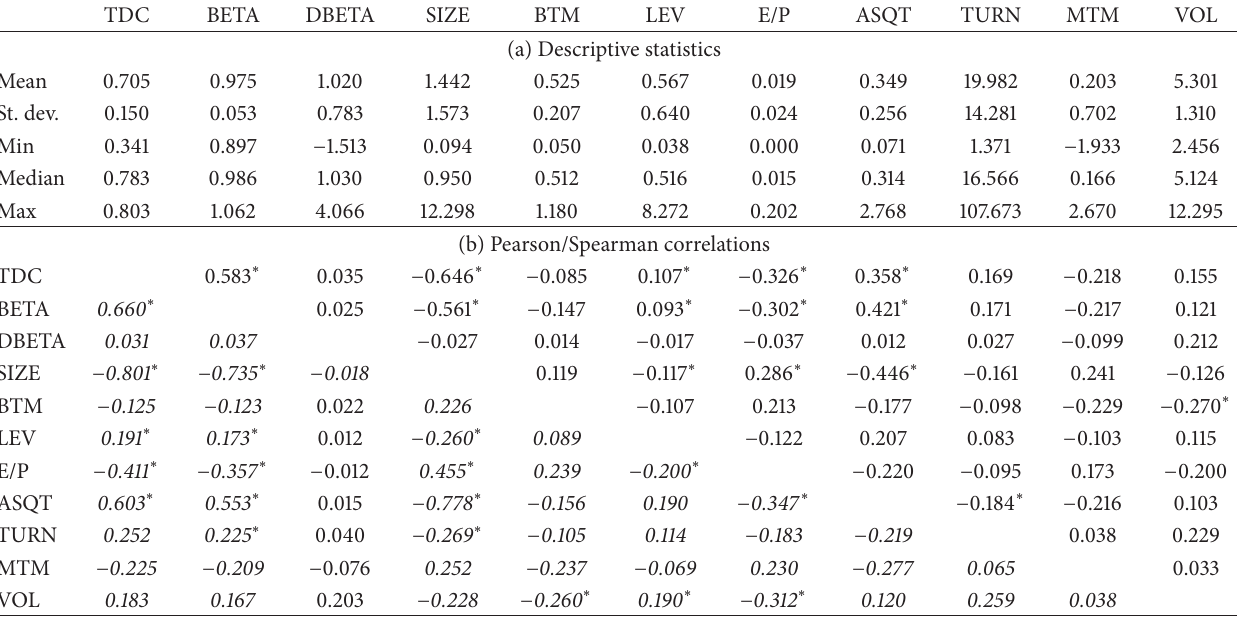
Table 2: Asset pricing factors. Panel (a) in this table contains the means, standard deviations, minimums, medians, and maximums of the variableswestudyinourpaper.Allstatisticsarecalculatedfromthefullsample,thatis,poolingallmonths.TDCandBETAarethepostranking portfolio TDCs and betas, while DBETA is downside beta. SIZE is the market capitalization of tradable shares in RMB million. BTM, LEV, and E/P represent the book-to-market, leverage, and earnings-price ratio, respectively. The following are the square root of Amihud’s liquidity measure denoted by ASQT and the Turnover denoted by TURN. MTM is the momentum calculated as the average percentage returns over the preceding two years, while VOL is the standard deviation of the weekly returns over the preceding two years. Panel (b) provides the time-series means of monthly correlations of the variables. The values in the upper lower triangular part are Pearson’s correlations, while the Spearman’s rank correlations in italic type are given in the lower triangular part. The correlations with superscript “ ∗ ” are significantly different from zero at 5%.